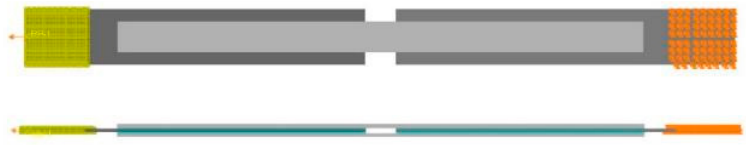
Figure 16. The static model of DLJ adopted in numerical analysis.